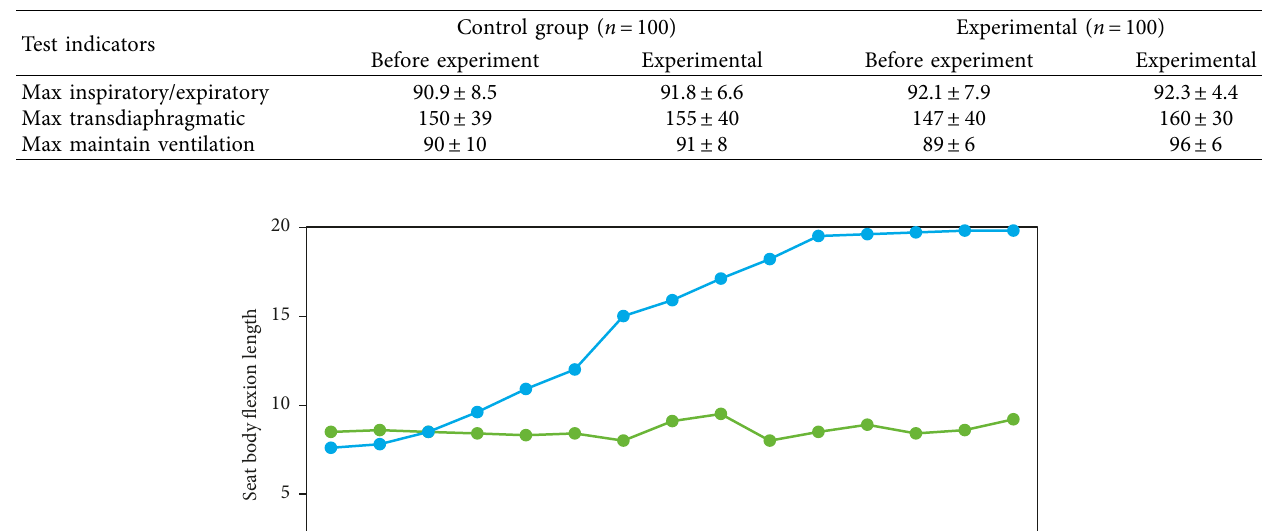
Table 3: Muscle endurance index matching test of subjects in the control group and experimental group before and after the